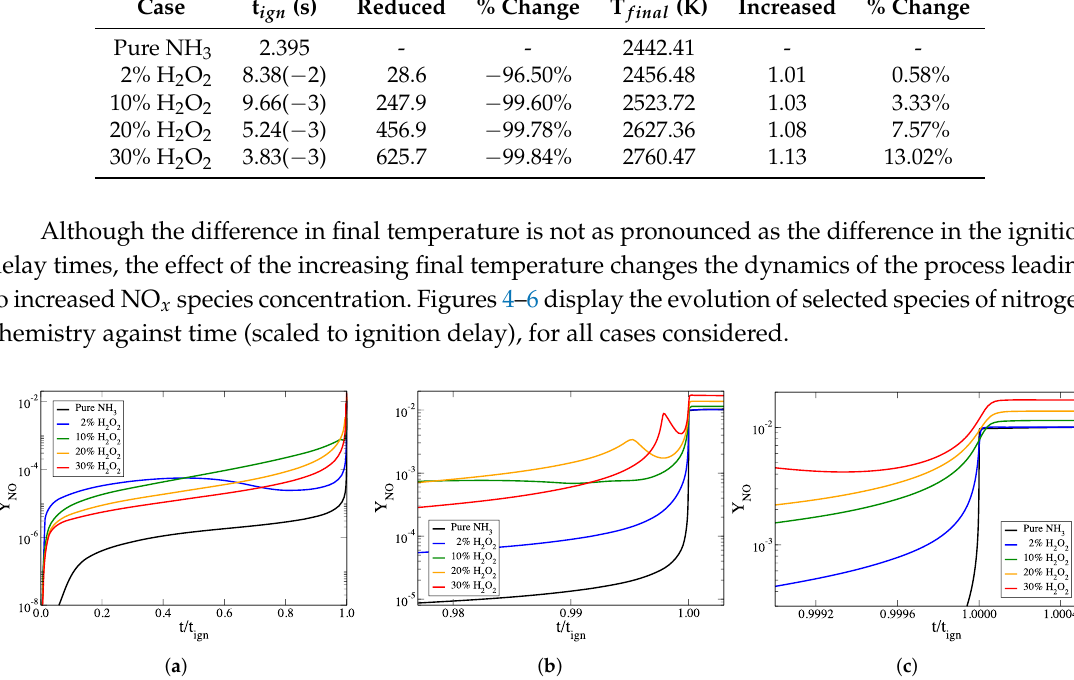
Figure 4. The temporal evolution of the mass fraction of NO against scaled time, for all cases considered: ( a ) the full explosive stage, ( b ) the final part of the explosive stage and ( c ) at ignition. The mass fraction of NO in the final products can be seen most clearly in panel ( c